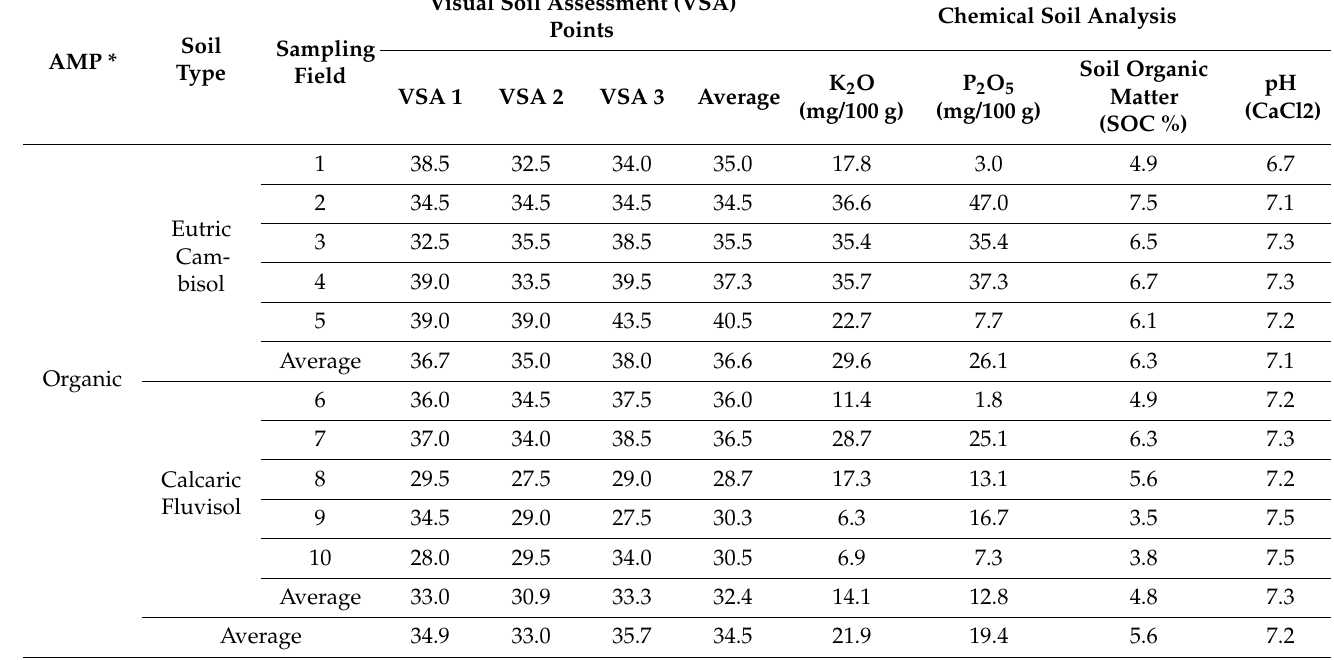
Table 3. Visual soil assessment (soil quality index) points per field for sampling date 2 June 2017, 25 July 2017, and 9 Septem- ber 2017, and chemical soil analysis of plant-available potassium (K 2 O) and phosphorus (P 2 O 5 ), pH, and organic matter (%) sampled after harvesting outside of the growing period (4 January 2018).